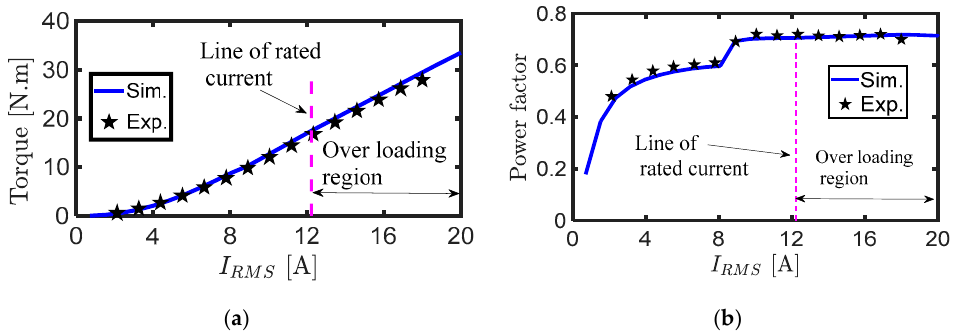
Figure 16. ( a ) Average output torque and ( b ) power factor at different line currents, at an optimal current angle, and at N r = 1000 rpm.